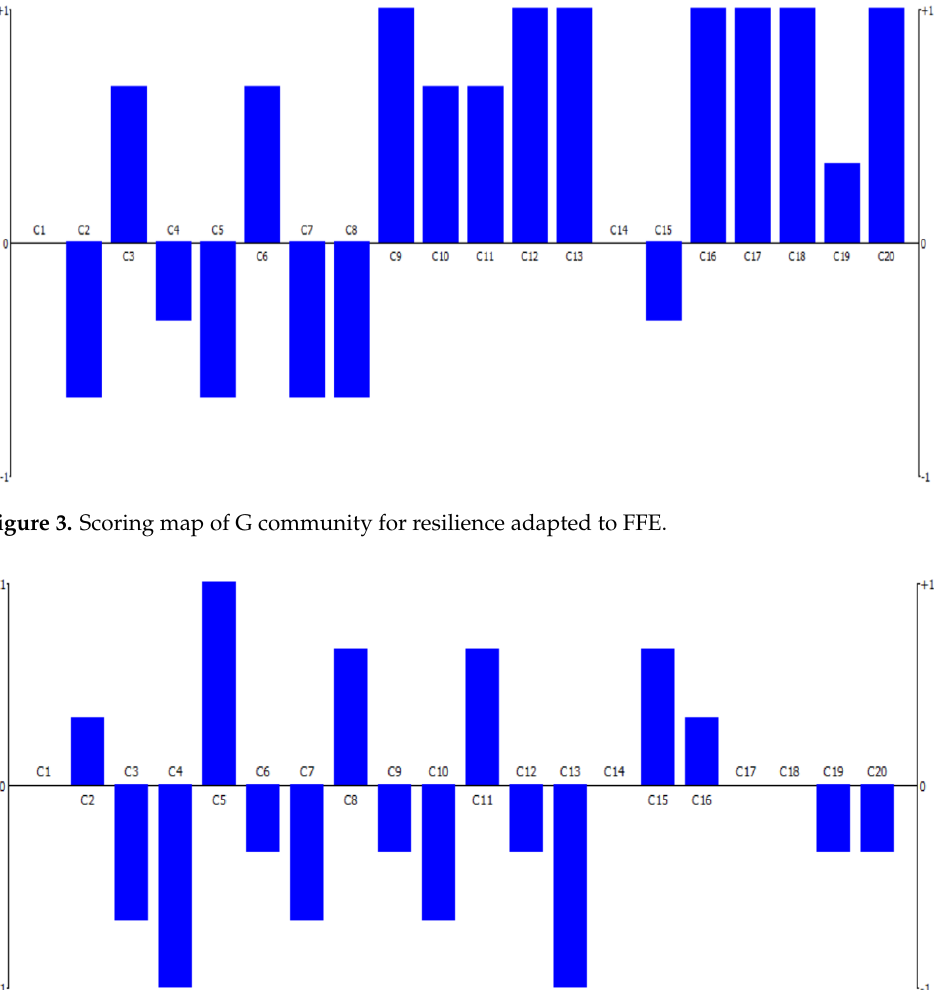
Figure 5. Scoring map of R community for resilience adapted to FFE.